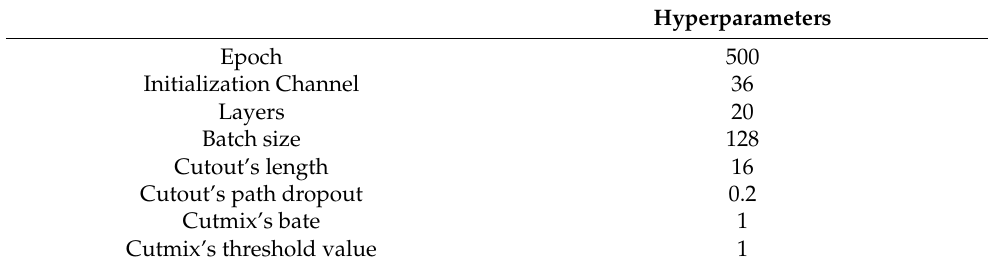
Table 5. Hyperparameter setting for structural verification phase of neural